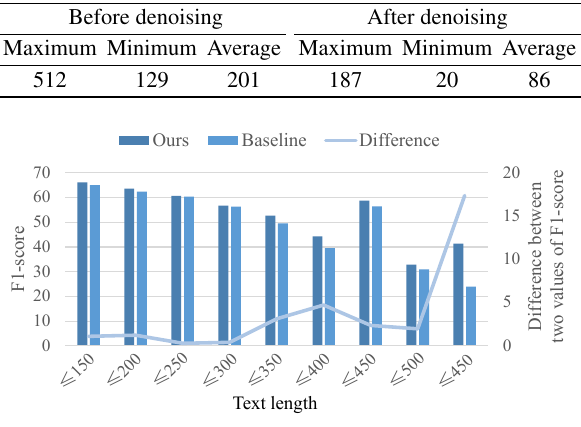
Fig. 9 Comparison of the results from our model and the baseline [18] in terms of the text length on DocRED. The histogram of the text length is divided into nine intervals, [0–150], (150–200], ..., [500, 550), with the F1-score from the two models. The grey line depicts the difference between two values of